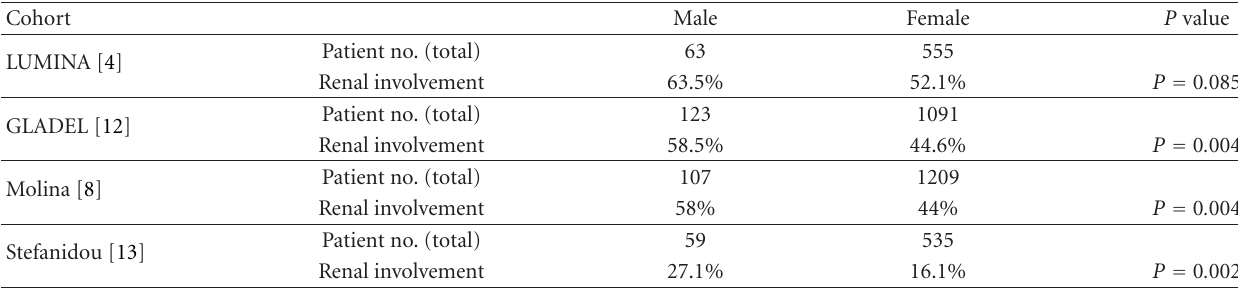
Table 2: Comparison of gender di ff erences in four separate cohorts of SLE